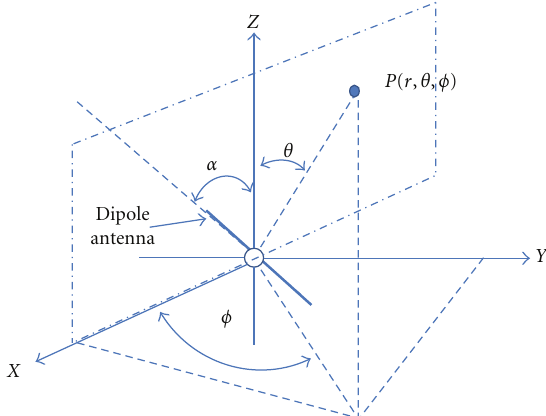
Figure 2: Half-wavelength dipole antenna and its coordinate